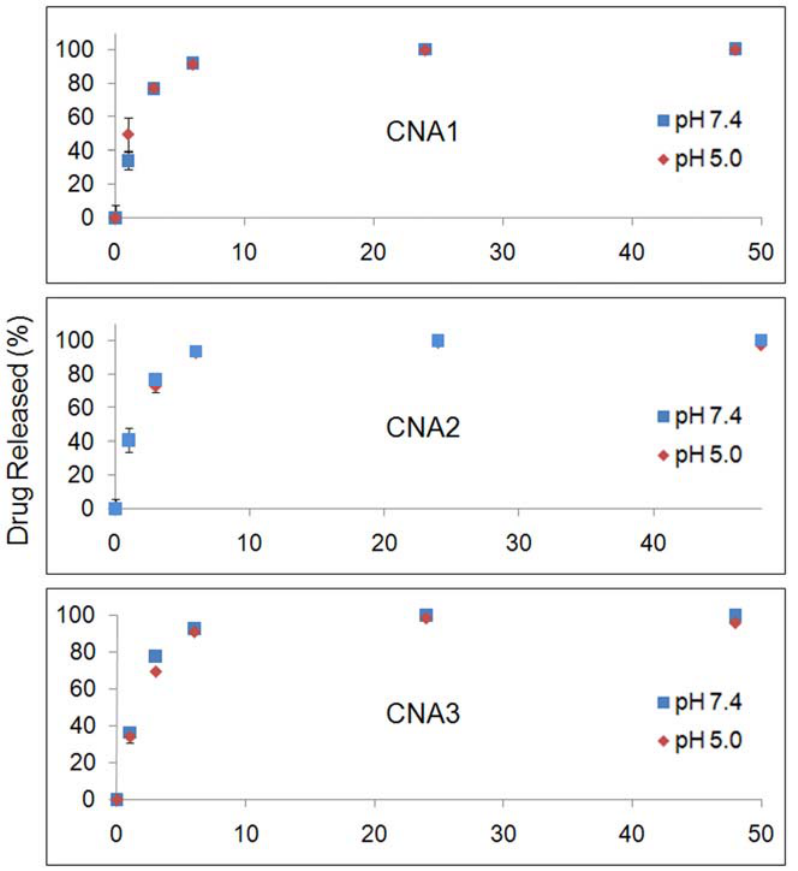
Figure 3. Drug release patterns of CNAs entrapping 17-AAG.